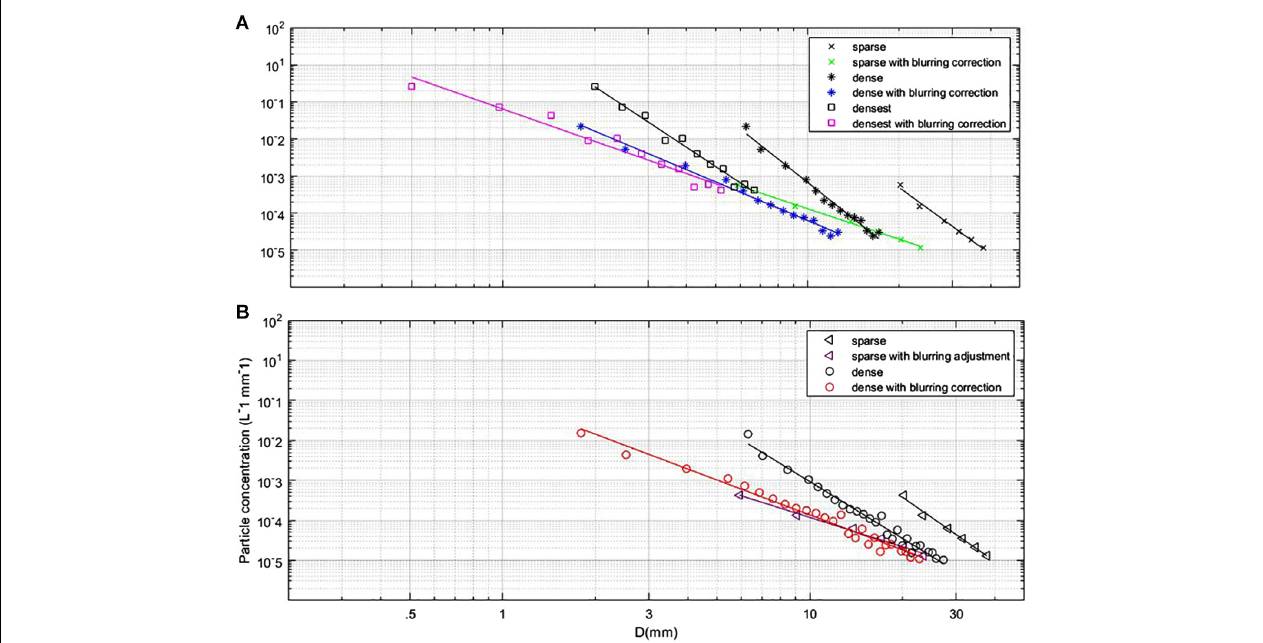
FIGURE 4 | (A) PSD averages from sparse, dense and densest scan modes with and without blurring correction for dusk time-series. (B) PSD averages for sparse and dense scan modes with and without blurring correction for dawn timeseries.